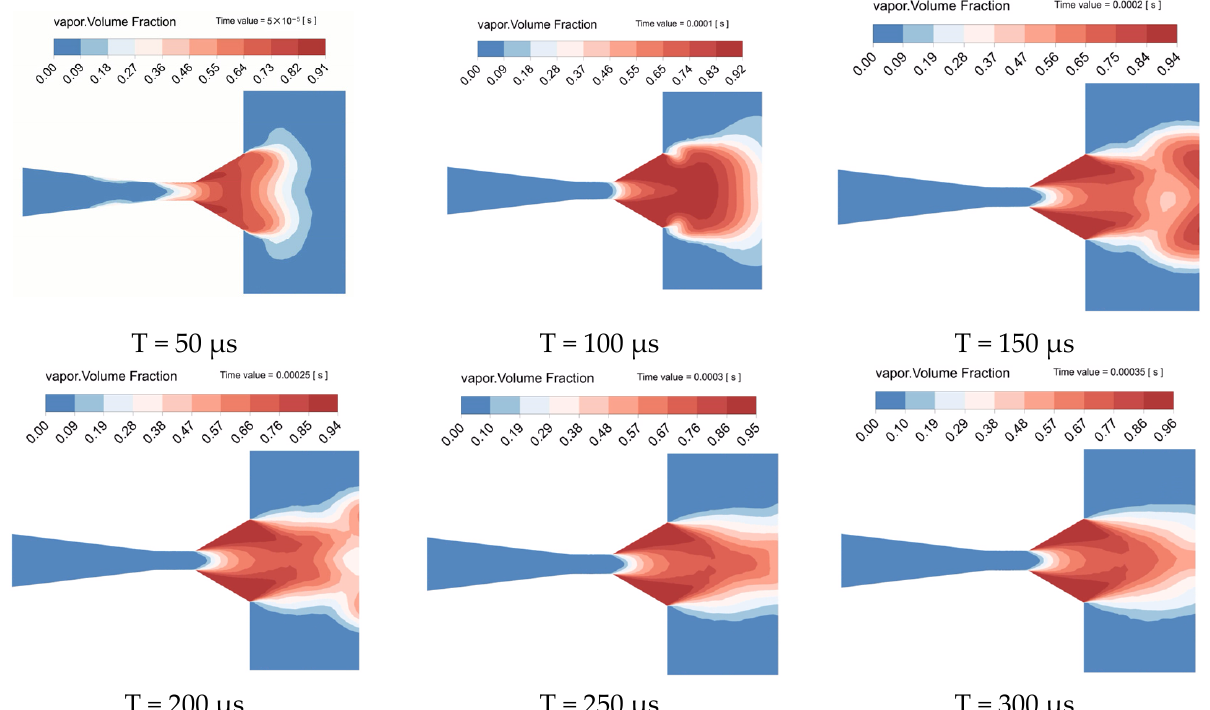
Figure 10. cavitation process of transient simulation. Figure 10. Cavitation process of transient